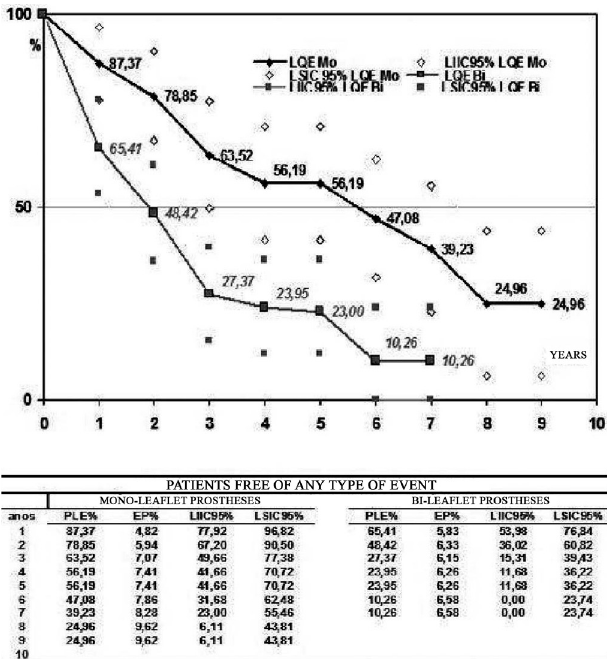
Fig. 1 - Curves and actuarial data showing the percentage of patients free from any type of event FAE (ordinate) with time - years (abscissa) for both types of prostheses studied. Mo = Mono-leaflet prosthesis; Bi = Bi-leaflet prosthesis; SE = standard error range; LLCI95% = lower limit of 95% Confidence Interval and ULCI95 % = Upper Limit of 95% Confidence Interval